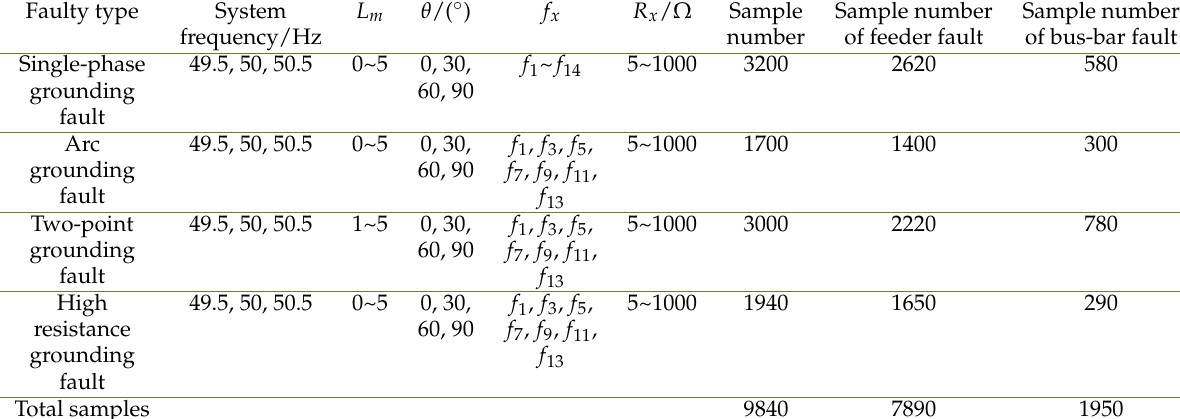
Table 4. Training sample set